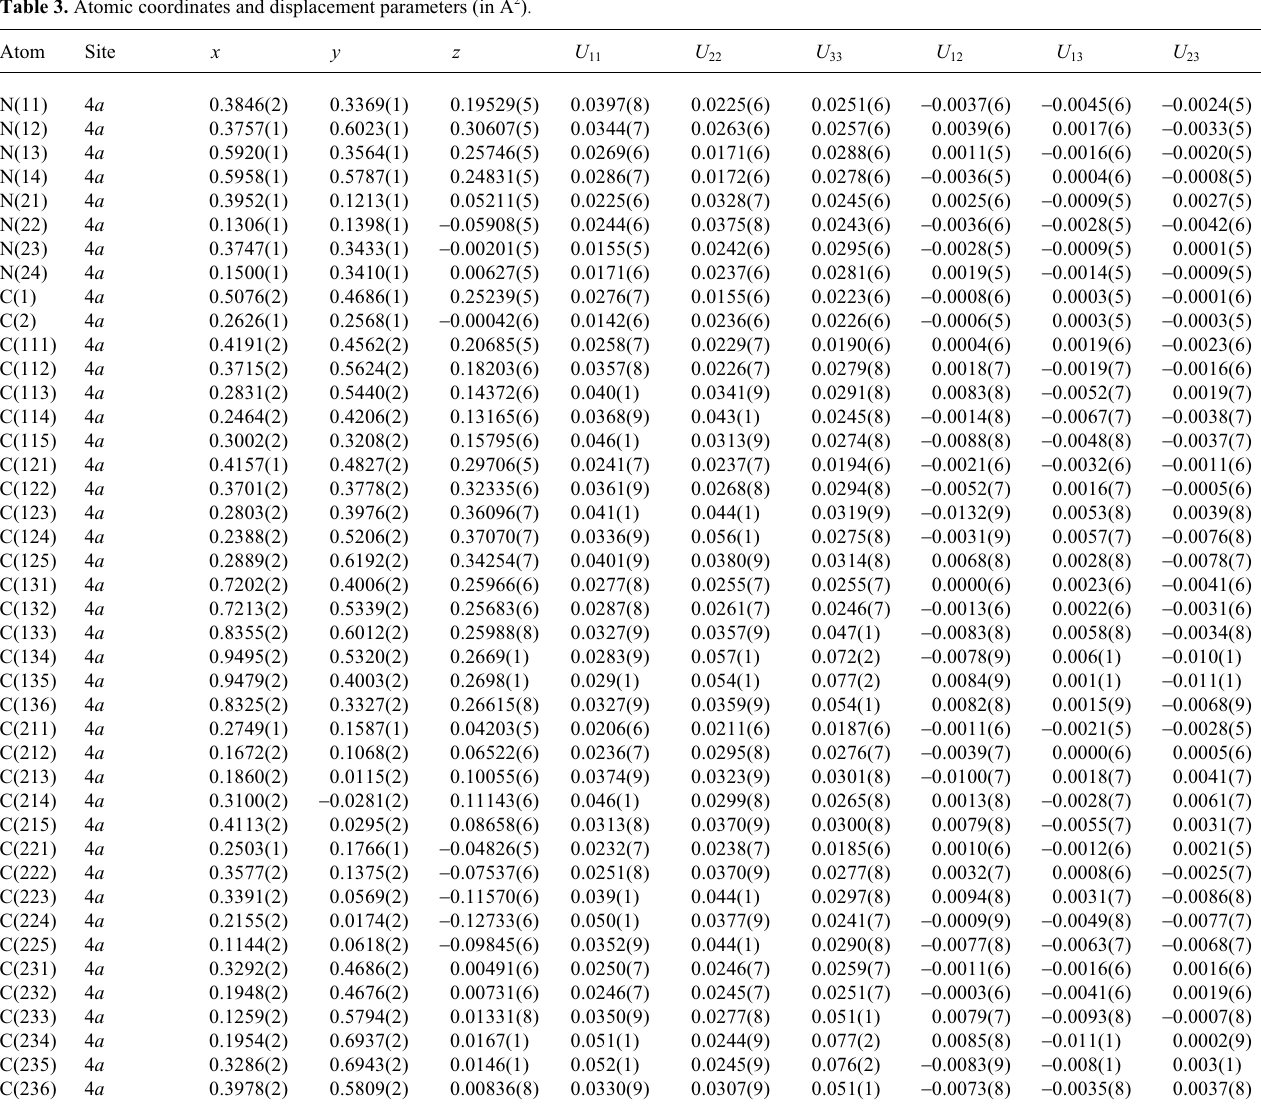
Table 3. Atomic coordinates and displacement parameters (in Å 2 )